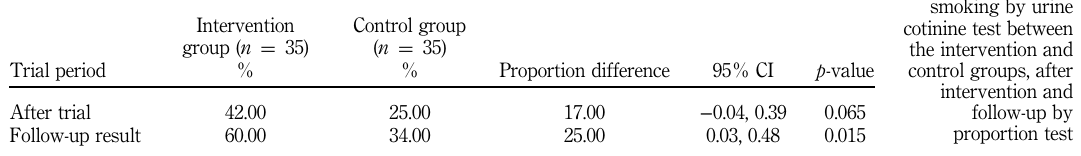
Table III. Comparison of not smoking by urine cotinine test